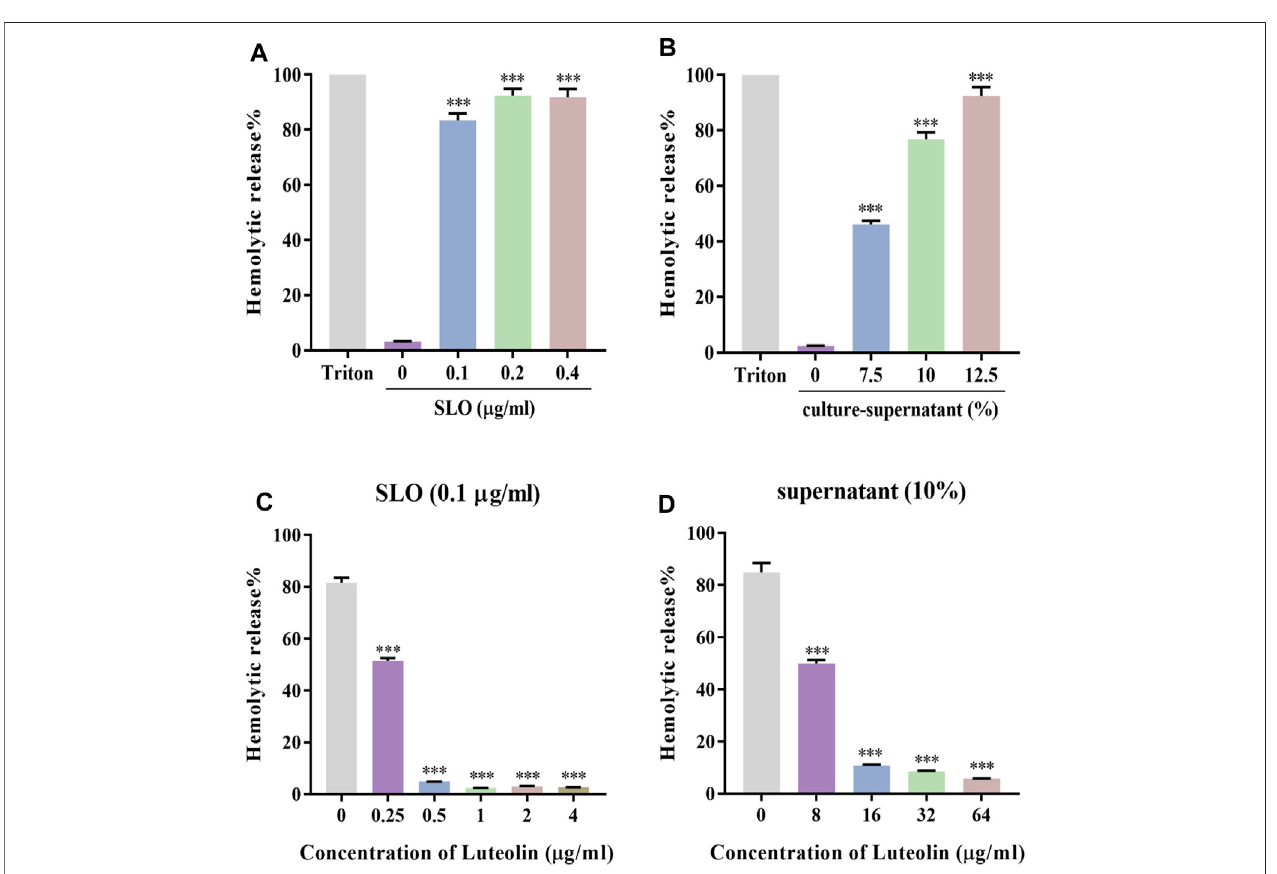
FIGURE 1 | Luteolin affected the hemolytic activity of SLO and culture-supernatant. (A,B) RBCs were treated with 0, 0.1, 0.2, and 0.4 μ g/ml of SLO or 0%, 7.5%, 10%,and 12.5% ofGASculture-supernatant for30 minat 37 ° C. (C) Effectofluteolin on RBClysisinducedbySLO. (D) Effectofluteolin on thehemolytic activity ofGAS culture-supernatant. The OD at 540 nm of each sample was obtained. Results were represented as the percentage of lysed RBCs (assuming as 100% the positive control) derived from three independent experiments ± SD (One-way ANOVA, *** p < 0.001 compared with cells treated with 0.1 μ g/ml of SLO in the absence of